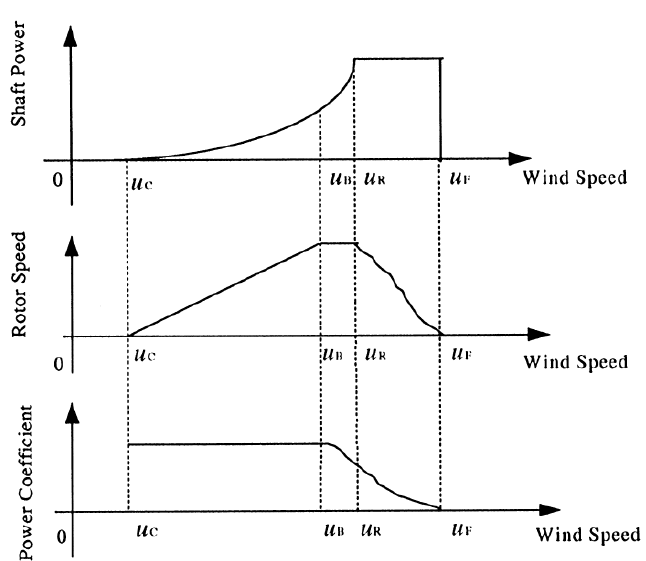
Figure 1. Turbine speed operation